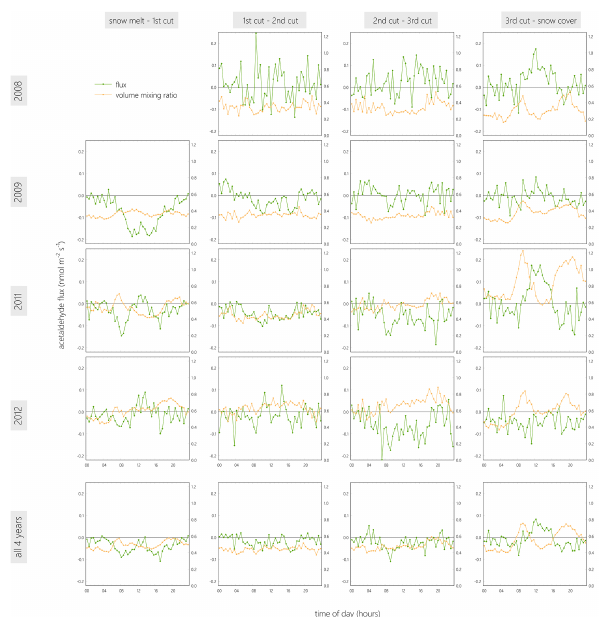
Figure 5. Diurnal cycles of acetaldehyde fluxes and volume mixing ratios (VMR) during different time periods over 4 years of VOC measurements. Management data were excluded from the